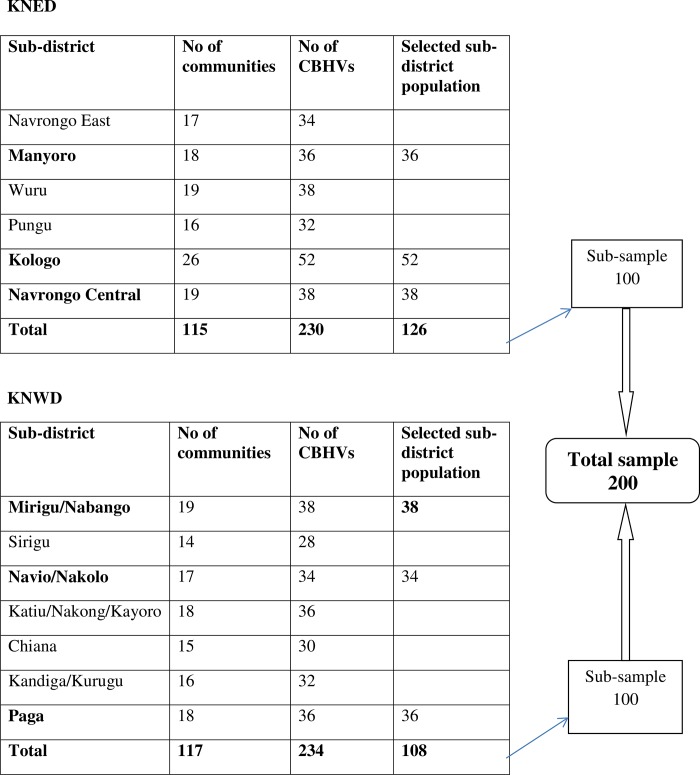
Sampling strategy.